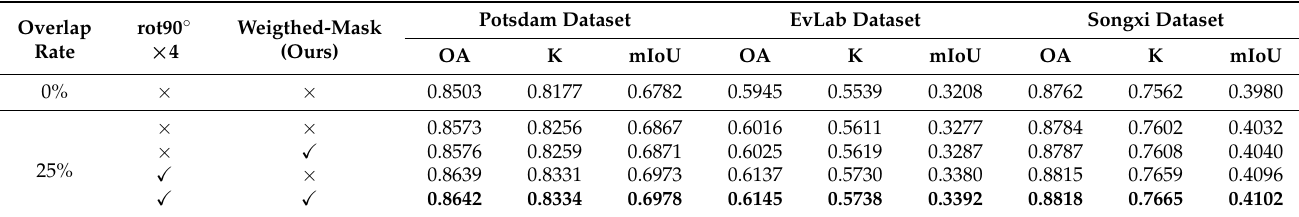
Table 5. Performances of different post-processing on SDFCNv2 in three experiment datasets. An overlap rate of 0% means there is no post-prediction. Overlap rot90 Rate